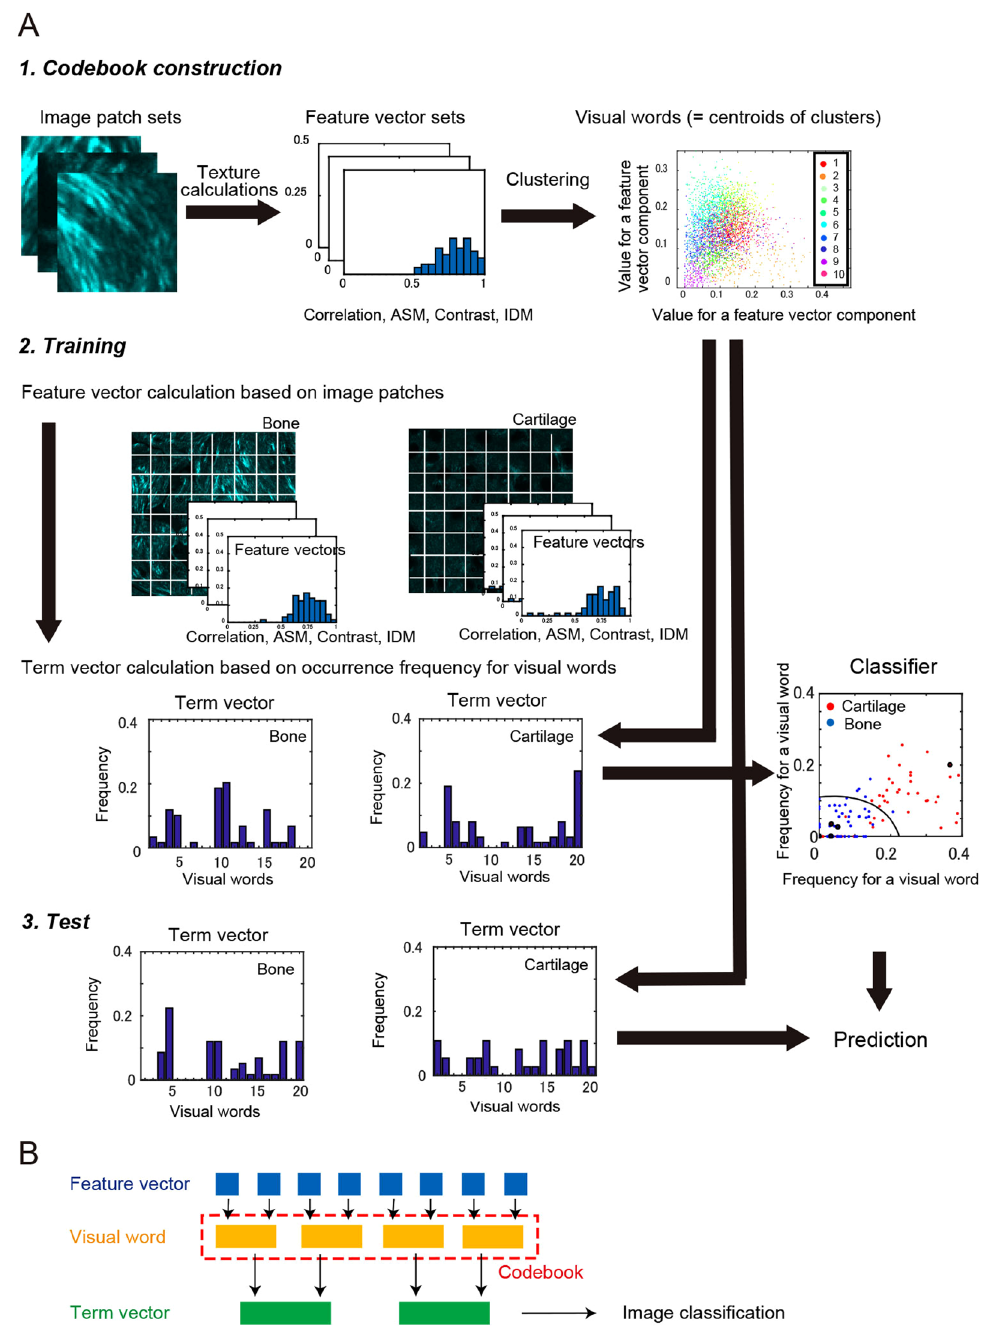
Figure 3. Schematic description of the BoF framework. ( A ) BoF comprises three steps, namely codebook construction, training, and test. In the codebook construction step, image patches are extracted and feature vectors calculated using the GLCM method. These vectors are used to create visual words by using the k -means clustering method. In the training step, an image is divided into patches that are subjected to feature vector calculation. A histogram of visual words occurrence (term vector) is subsequently calculated for each image. Based on these data, the classifier is constructed. In the test step, image prediction is performed based on the SVM (or multi-class ECOC) classifier. ( B ) Hierarchical relationship between terminologies: feature vector, visual word, codebook, and term vector. Beginning with feature vectors derived from image patches, visual words are created using a k -means clustering method. Codebook is a collection of visual words. Term vectors are histograms of visual word occurrence within an As in the test for the sectional SHG images, we evaluated the prediction accuracy of the texture- and SURF-BoF frameworks. The results were summarized in the confusion matrices (Table 2 and Supplementary Table 4). Overall, the prediction tests for the texture-BoF were more accurate than those for the SURF-BoF,